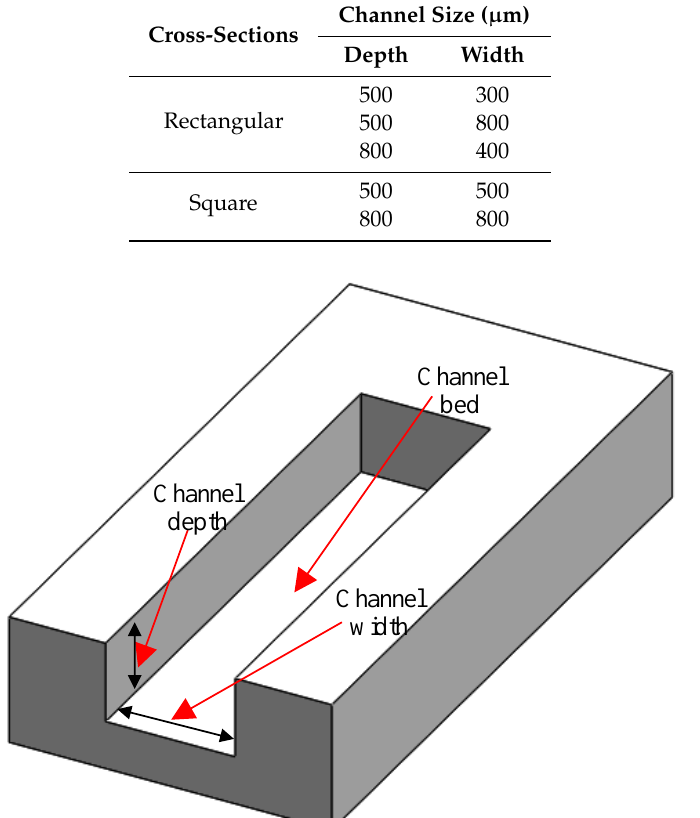
Table 2. Dimensional specification of microchannels used in this study.